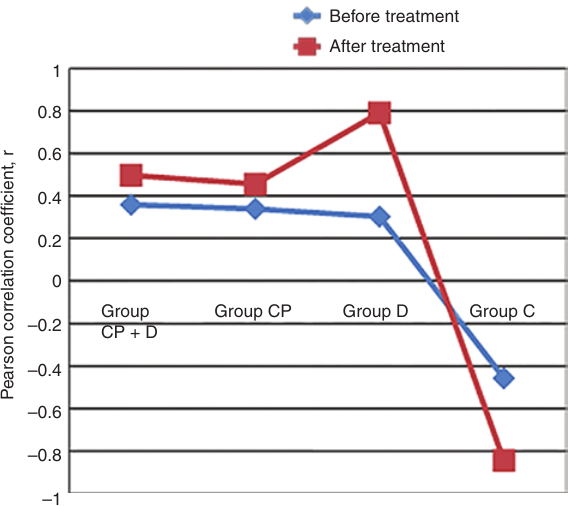
Figure 3: Intergroup correlation of plasma fibrinogen and salivary neopterin level before and after treatment.